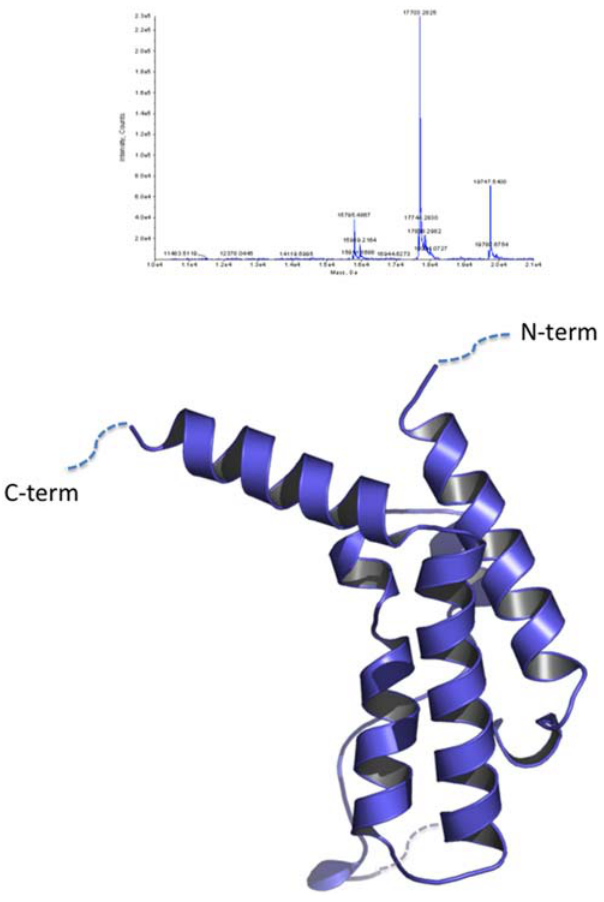
Figure 2. PF10_0328 proteolytic cleavage and crystal structure. (A) Mass spectrometry analysis of chymotrypsin-treated protein crystals. The major peak corresponds to a C-terminal cleavage of 17 residues, largest mass peak corresponds to full length construct, and the third peak corresponds to the C-terminal cleavage plus His-tag cleavage. (B) Ribbon diagram of PF10_0328 bromodomain. Dotted lines signify missing density.